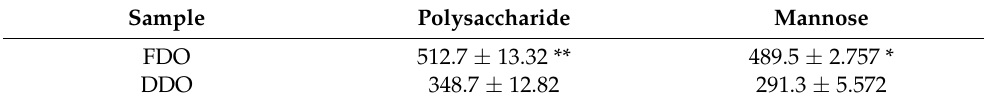
Table 1. The content of Polysaccharide and Mannose in FDO and